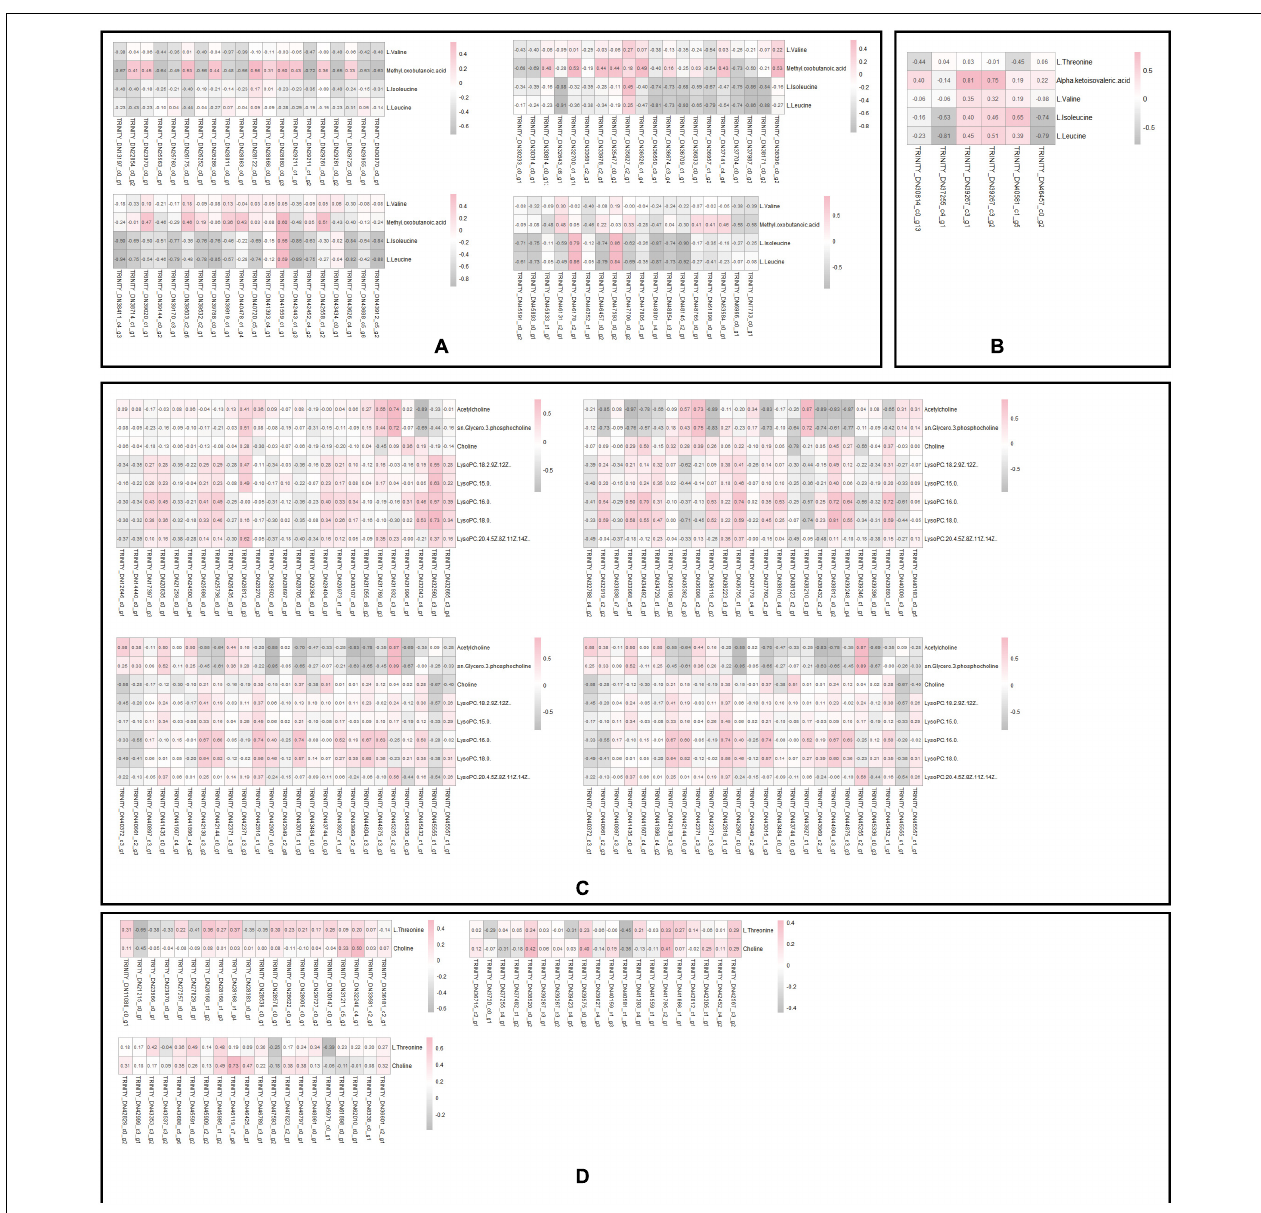
FIGURE 8 | (A) Correlation analysis between the differential metabolites and DEGs of Valine, leucine and isoleucine degradation. Pink indicates positive correlation, and gray indicates negative correlation. (B) Correlation analysis between the differential metabolites and DEGs of Valine, leucine and isoleucine biosynthesis. Pink indicates positive correlation, and gray indicates negative correlation. (C) Correlation analysis between the differential metabolites and DEGs of Glycerophospholipid metabolism. Pink indicates positive correlation, and gray indicates negative correlation. (D) Correlation analysis between the differential metabolites and DEGs of Glycine, serine and threonine metabolism. Pink indicates positive correlation, and gray indicates negative correlation.